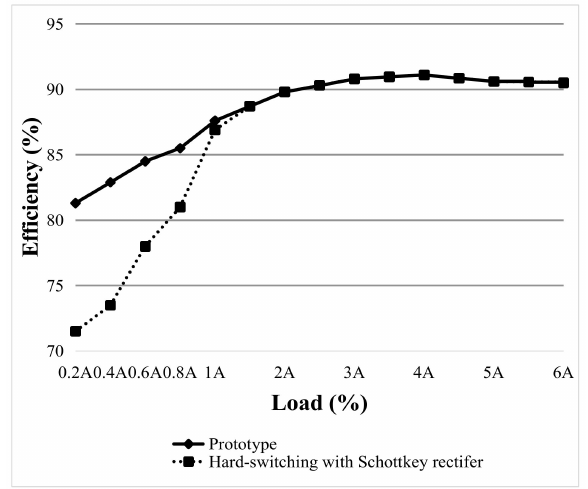
Figure 14. Efficiency comparison between the prototype and traditional forward converter at 28 V